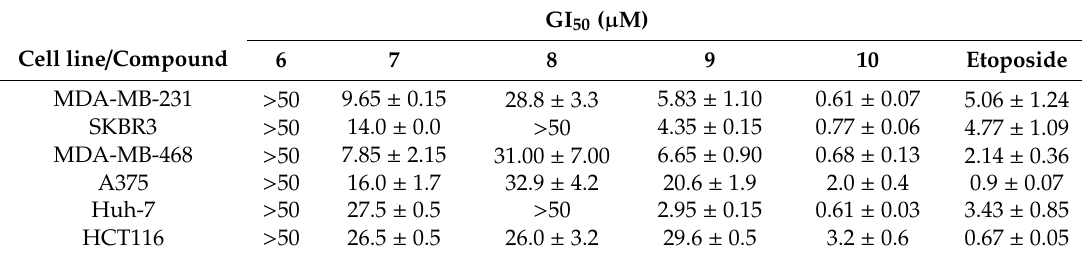
Table 1. E ff ect of compounds 6 – 10 on the growth of human cancer cell lines. GI 50 ( µ